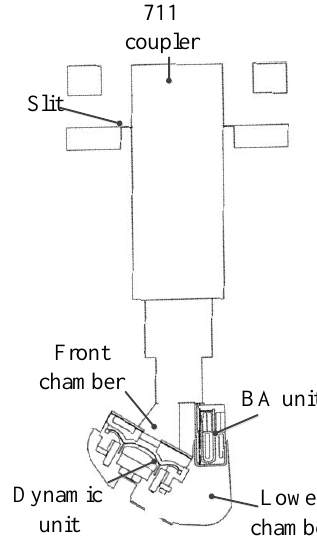
Figure 7. Acoustic model of the hybrid earphone.